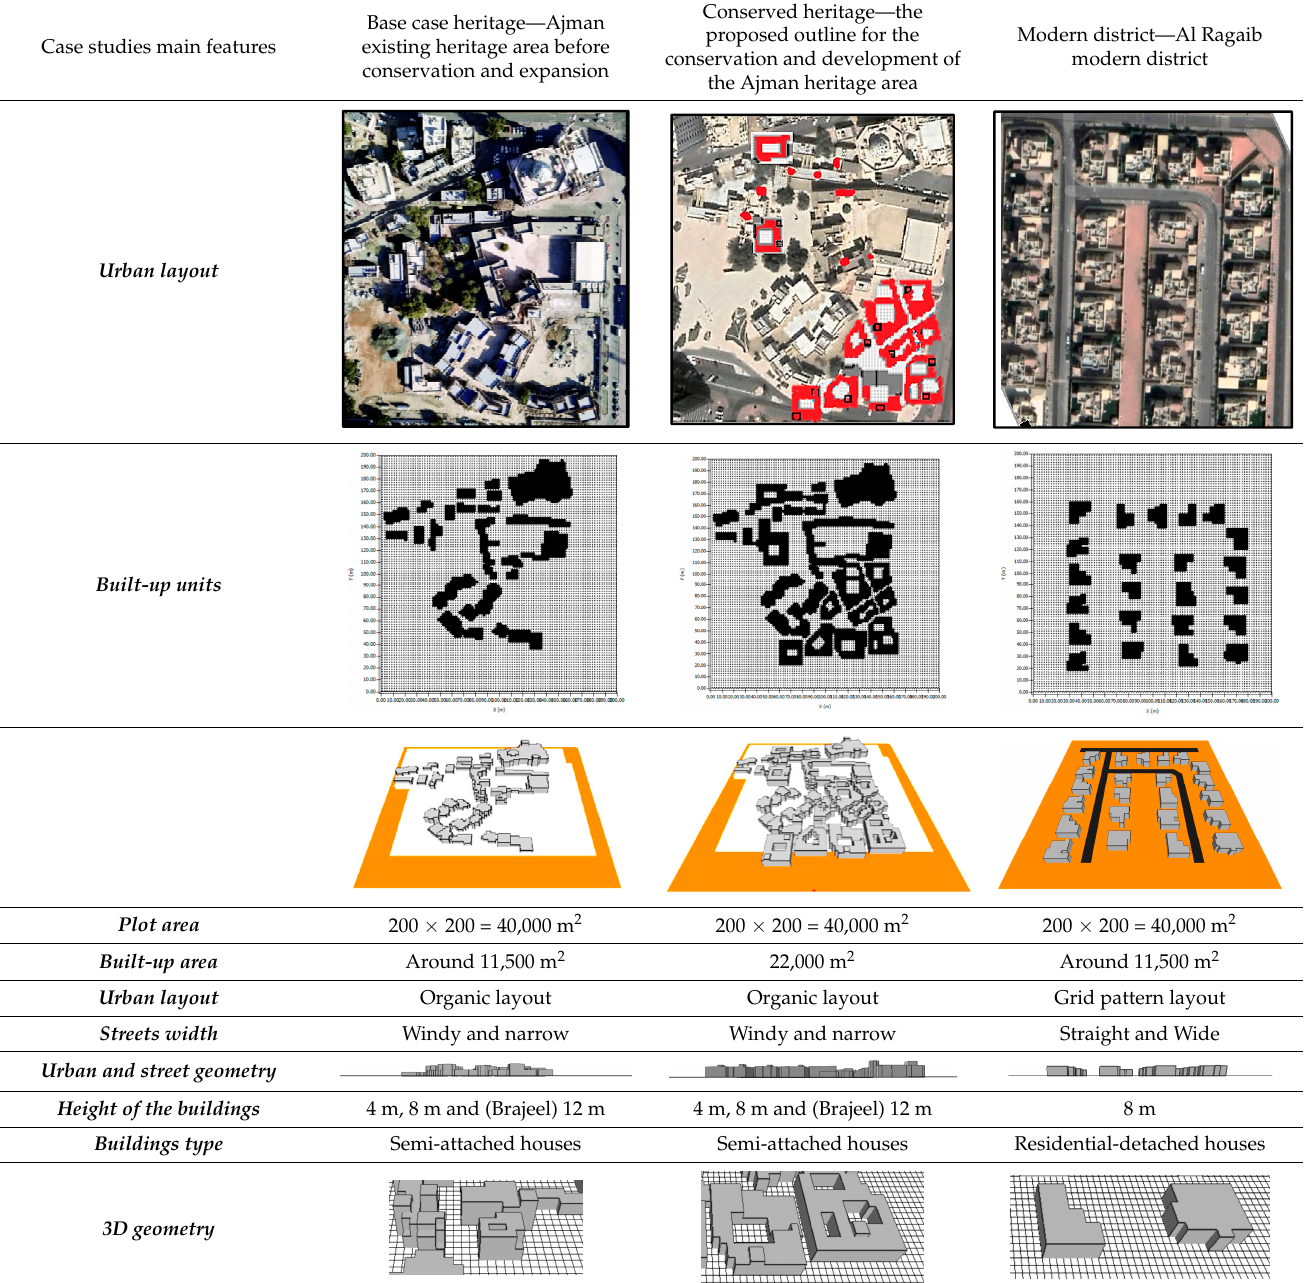
Table 4. Simulation criteria for the case